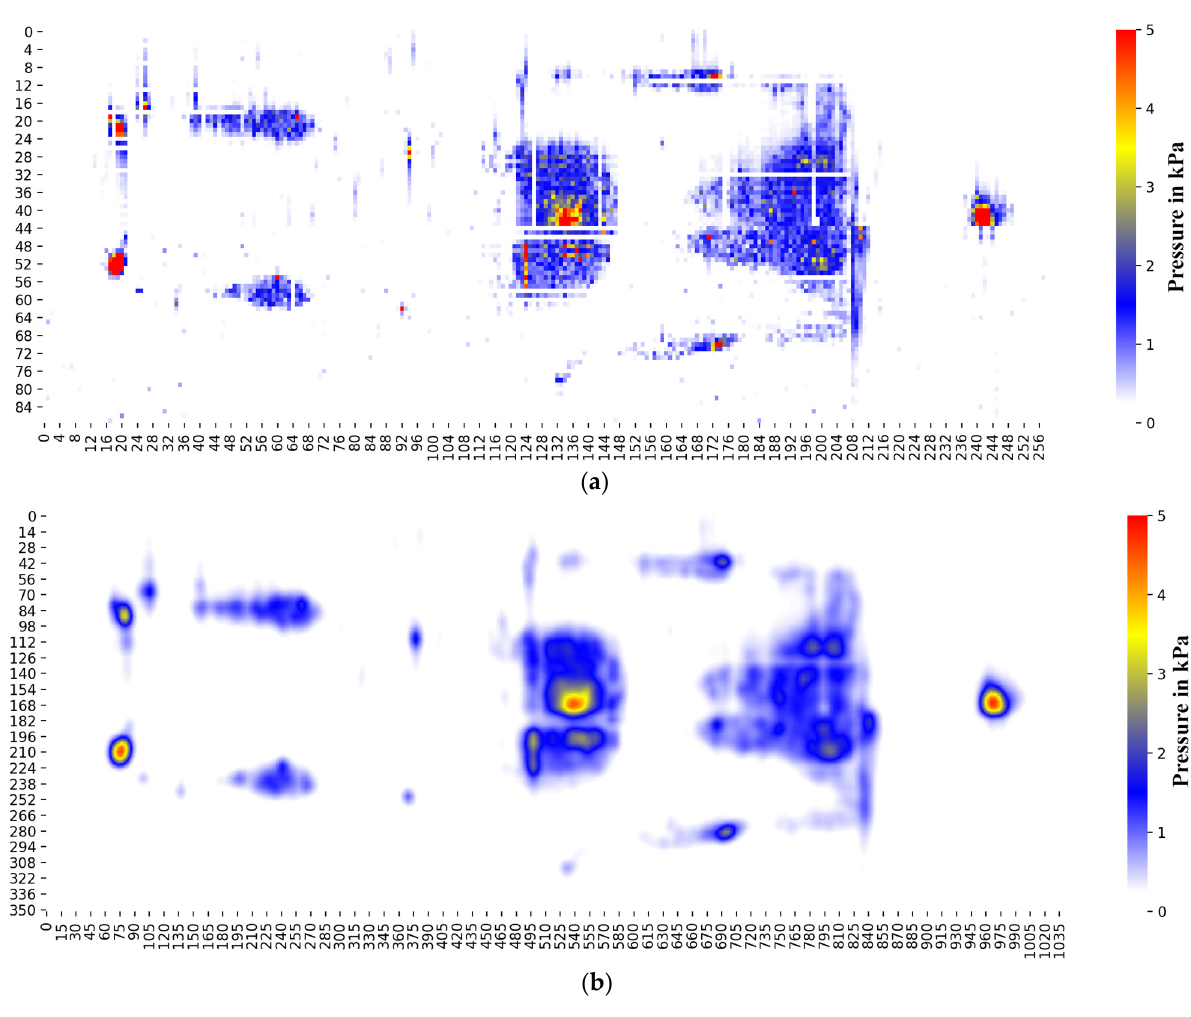
Figure 8. Heatmap texture: ( a ) Without Keras; ( b ) With Keras.